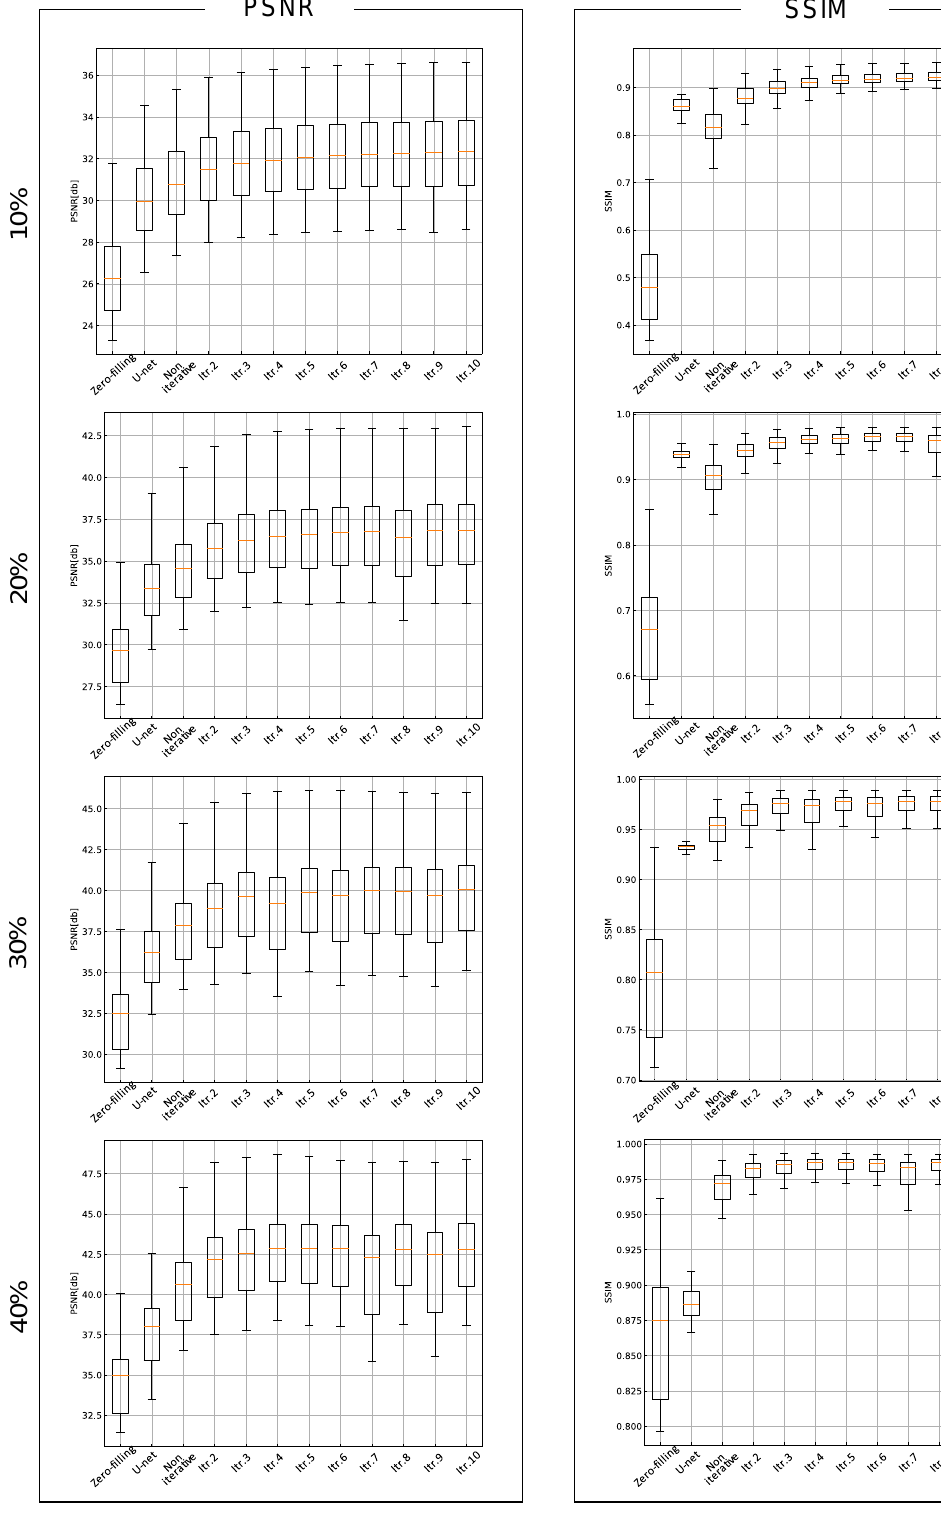
Figure 6. Quantitative results in terms of PSNR and SSIM values obtained by different methods for all radial sampling masks. In each plot, the yellow line within the box represents the median; the lower and upper lines of the box represent the 25th and 75th percentiles, respectively; and the lower and upper horizontal lines above and below each box (whiskers) represent the minimum and maximum values, respectively.